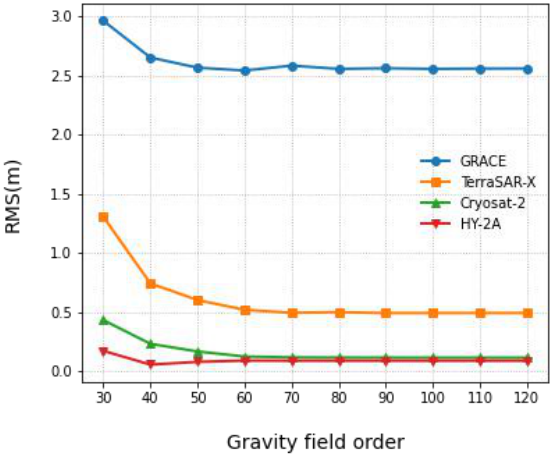
Figure 6. LEO Orbit Prediction Error in the radial direction of different satellites for different orders for 1-day